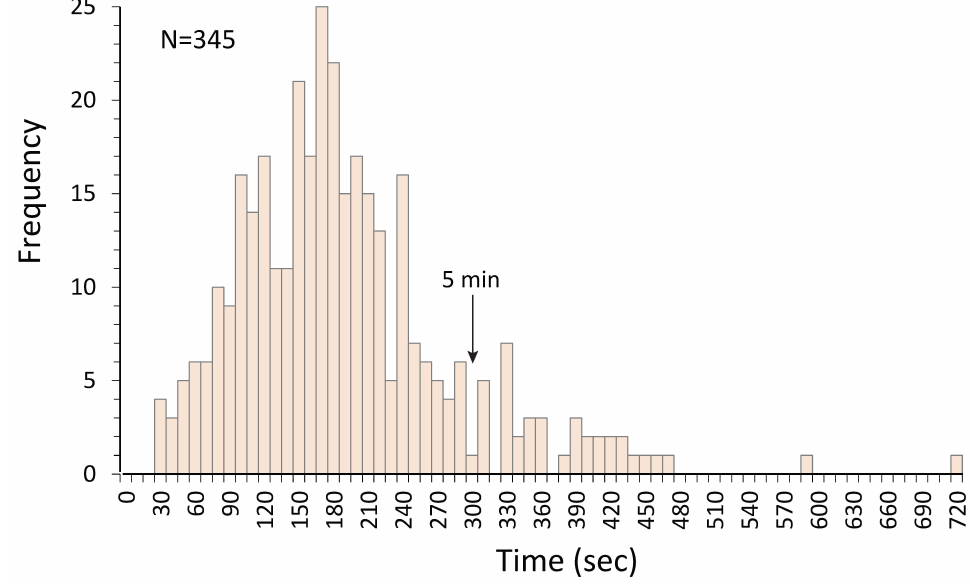
Figure 1. Histogram showing the distribution of time spent collecting non-matrix observations on more than 345 boxes of core using the NMQP method. more than 345 boxes of core using the NMQP